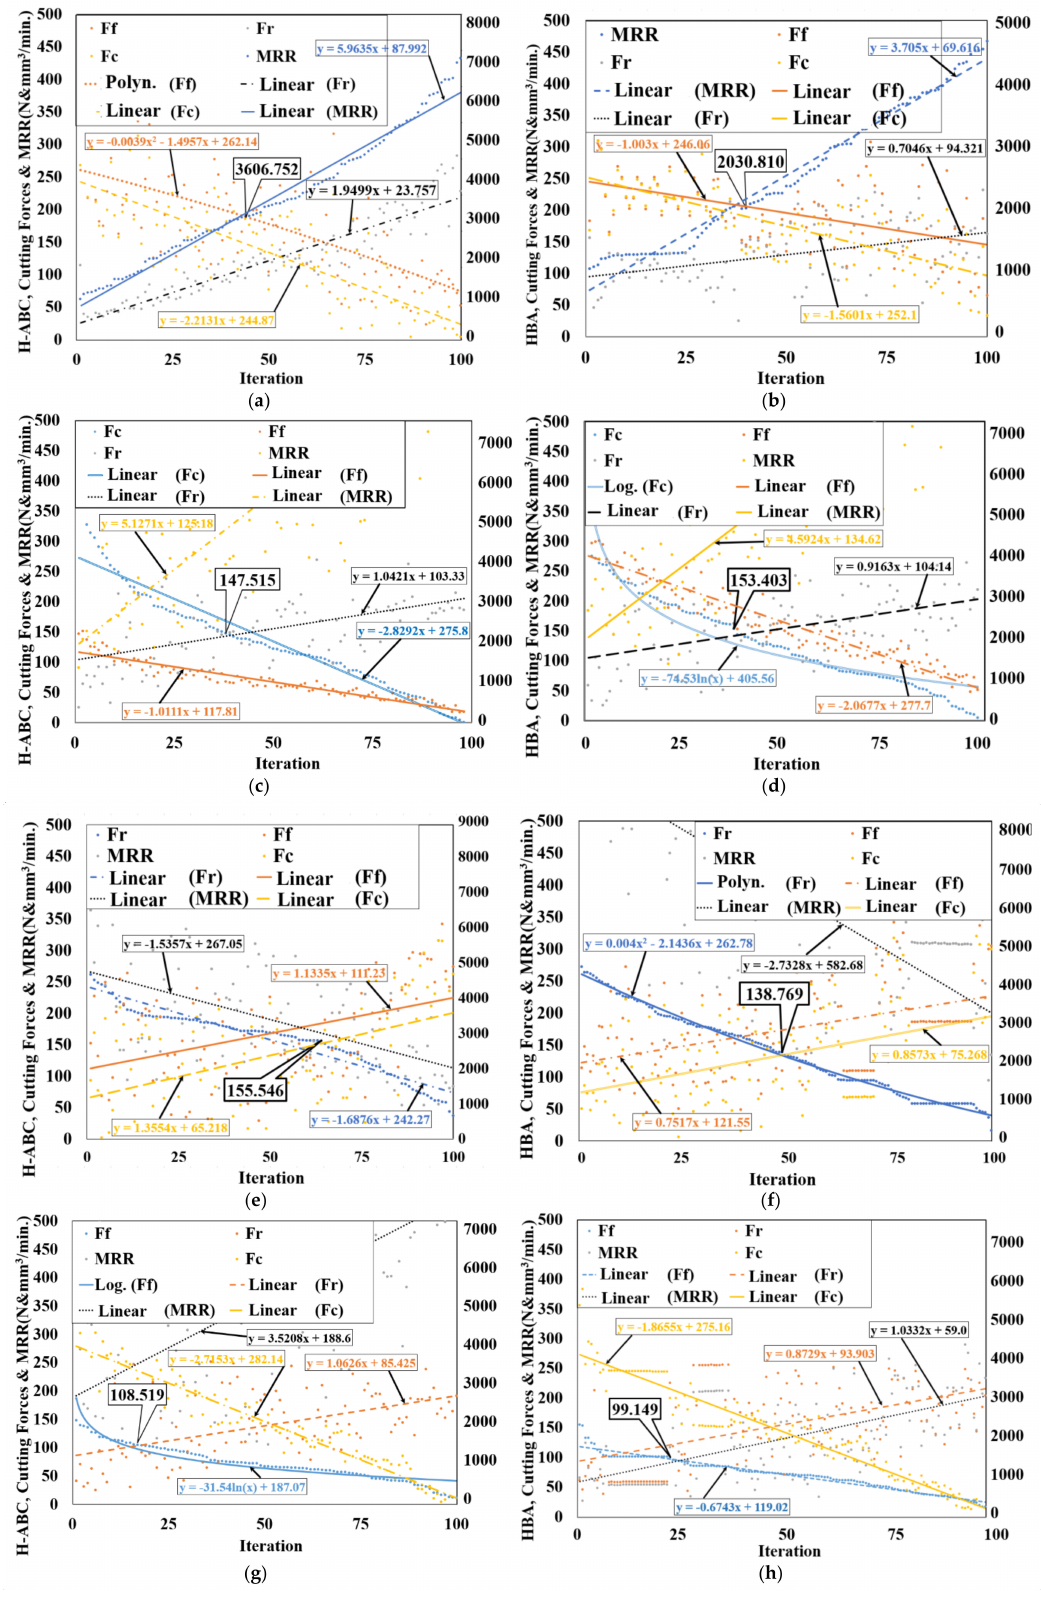
Figure 5. Optimal MRR, Fc, F F , and F R values obtained by using H-ABC and HBA algorithms. ( a ) Optimization of MRR by using H-ABC and ( b ) by using HBA, ( c ) optimization of Fc by using H-ABC and ( d ) by using HBA, ( e ) optimization of F R by using H-ABC and ( f ) by using HBA, and ( g ) optimization of F F by using H-ABC and ( h ) by using